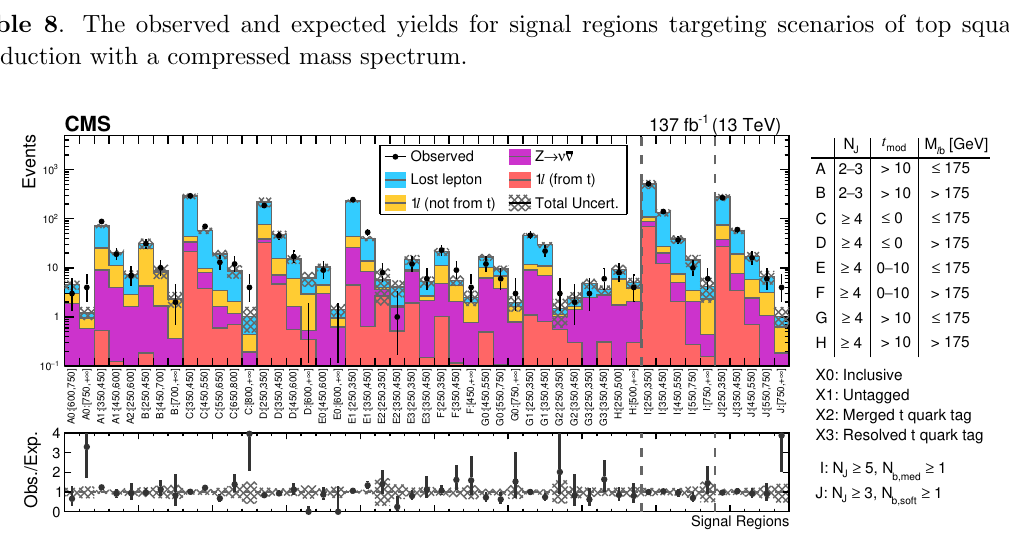
Figure 5 . The observed and expected yields in tables 7 and 8 and their ratios are shown as stacked histograms. The lost lepton and 1 ‘ (not from t) are estimated from data-driven methods, while 1 ‘ (from t) and Z ! (cid:23) (cid:22) (cid:23) backgrounds are taken from simulation. The uncertainties consist of statistical and systematic components summed in quadrature and are shown as shaded bands. for the possible contributions of signal events to the control samples. These corrections are typically around